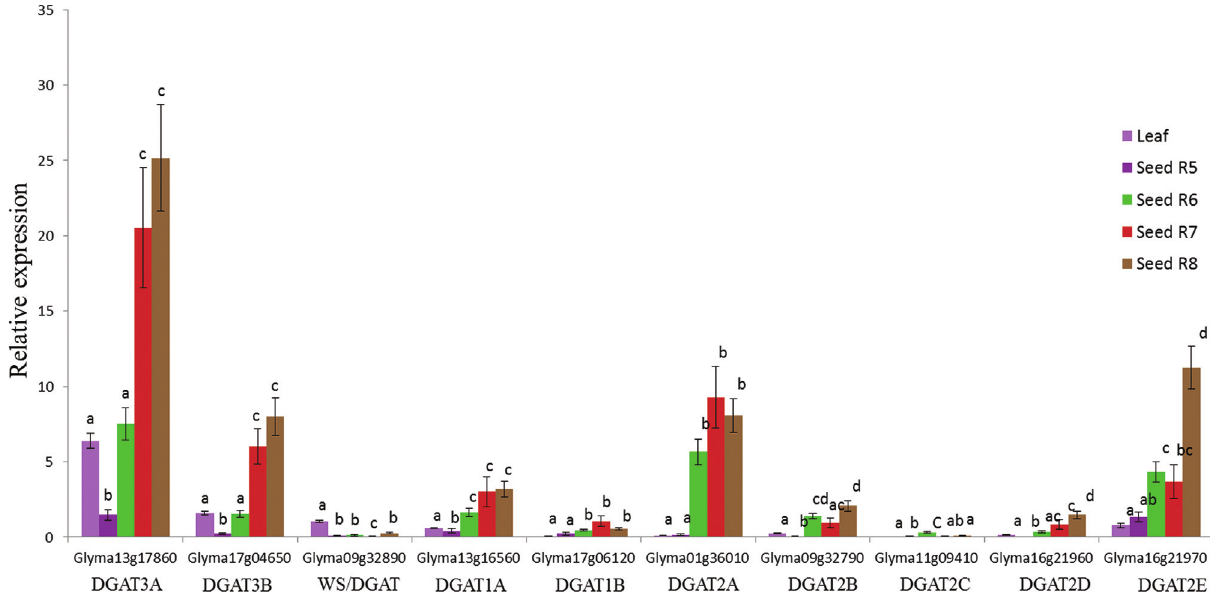
Figure5 -Expressionprofilesofthe DGAT1 , DGAT2 , DGAT3 and WS / DGAT genesduringsoybeanseeddevelopmentusingRT-qPCRanalysis.Expres- sion profiles of each DGAT3 (Glyma13g17860, Glyma17g04650), WS / DGAT (Glyma09g32890) , DGAT1 (Glyma13g16560, Glyma17g06120) and DGAT2 (Glyma01g36010, Glyma09g32790, Glyma11g09410, Glyma16g21960, Glyma16g21970) genes. The comparison of expression profiles be- tween DGAT3 and WS / DGAT geneswasdoneusinganendogenousnormalizationwiththeleaftissueof WS / DGAT gene.Standarderrorbarsarebasedon four biological replicates. One-way ANOVA followed by the Tukey’s test was used in the statistical analysis of the RT-qPCR data. mRNA input normal- ization was performed with four constitutive genes ( Actin , ELF , CPY and TUA